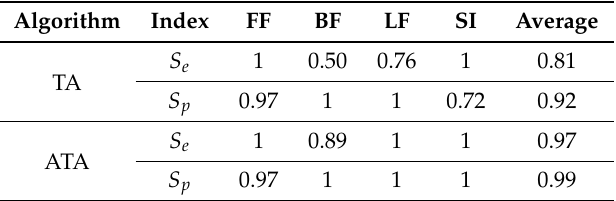
Table 6. Comparison between the TA and ATA